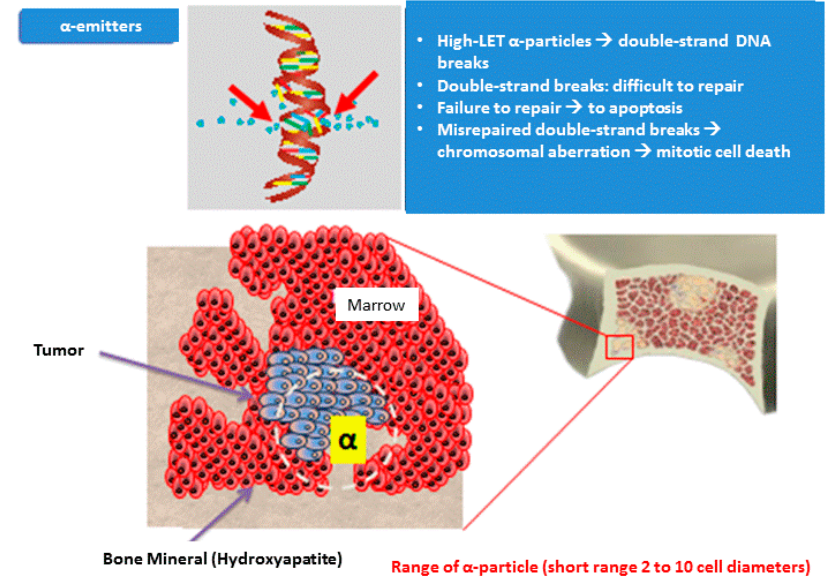
Figure 1. The high linear energy transfer induced by the α emitters (100 keV/µm) causes high frequencies of DNA double helix breaks in adjacent tumor cells. These are difficult to restore by cellular repair damage mechanisms, resulting in a powerful cytotoxic effect (cell death for apoptosis).